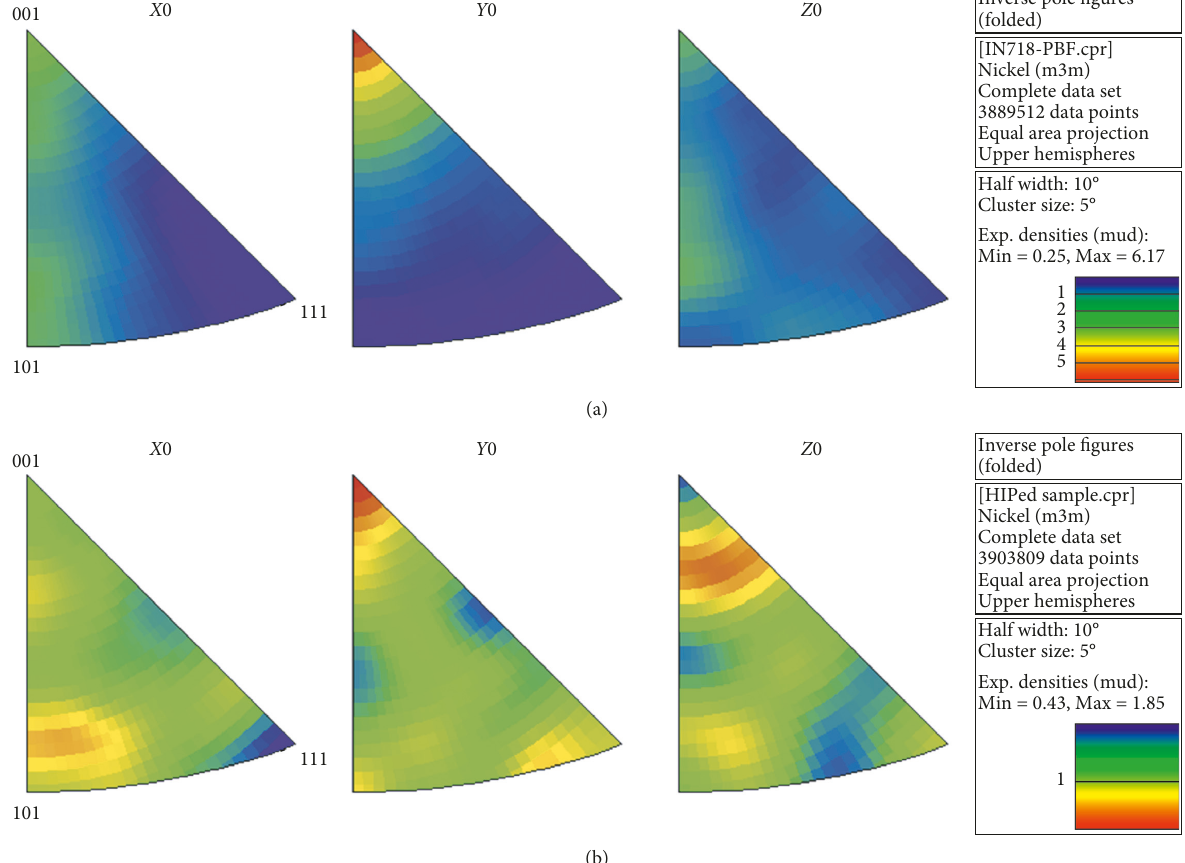
Figure 11: Inverse pole figure constructed based on 4 million data-points from the scanned area along the sample principal axes X 0, Y 0, and Z 0 for (a) solution-treated and (b) HIP-treated